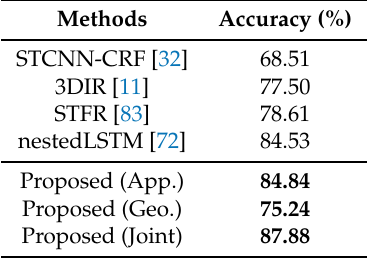
Table 7. The performance comparison of the recognition accuracy in the MMI dataset (%).